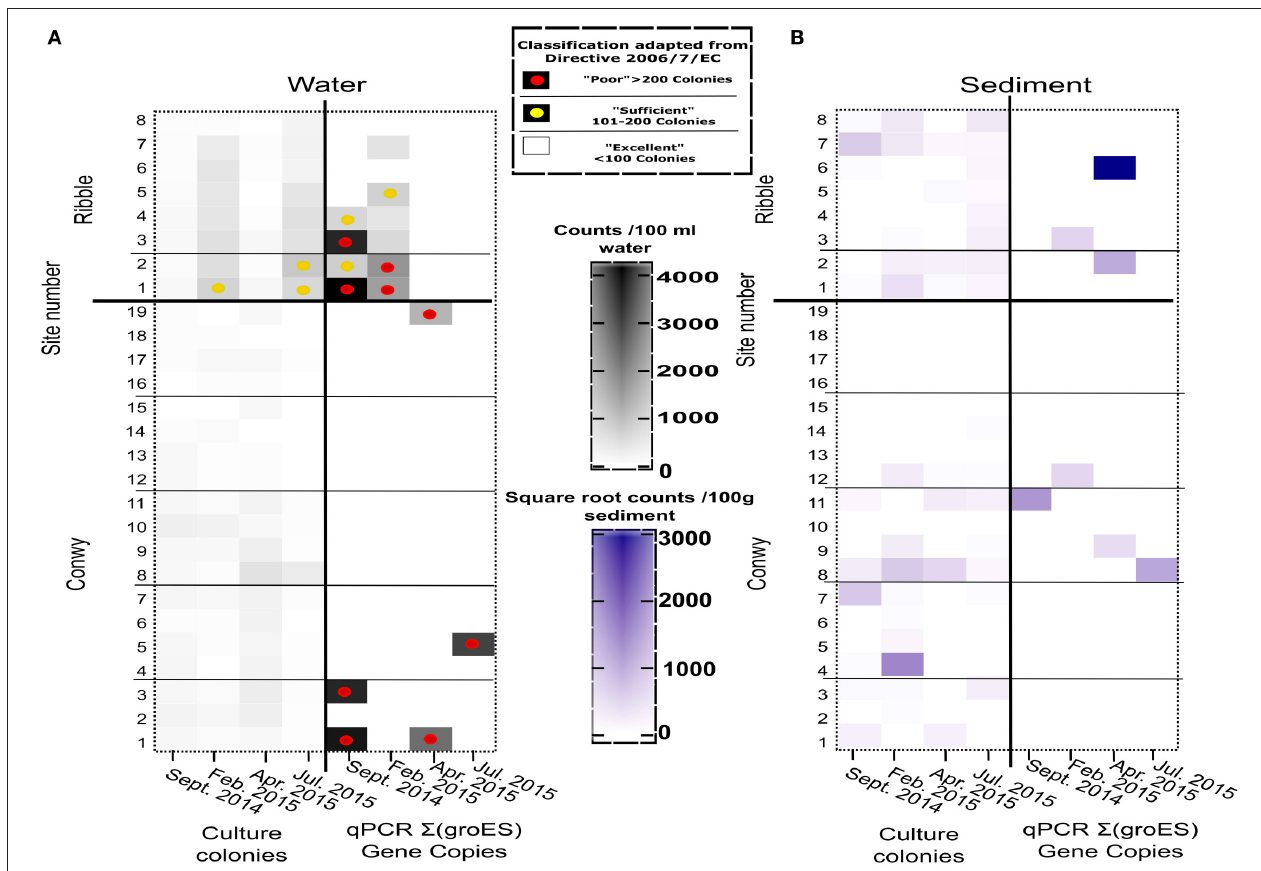
FIGURE 4 | (A) Intestinal enterococci abundance in the Conwy Estury (sites 1–19) and the River Ribble (sites 1–8) for sampling events (Water (CFU/100ml or GC/100ml), (B) Sediment (CFU/100 or GC/100 g wet weight). Sample sites compliance indicated by superimposed circles for Framework Directive 2015 2006/7/EC for water (see box). Samples without circle indicates better than “Excellent” water quality for Coastal and Transitional Waters. qPCR copies represent sum of Enterococcus faecium and E.